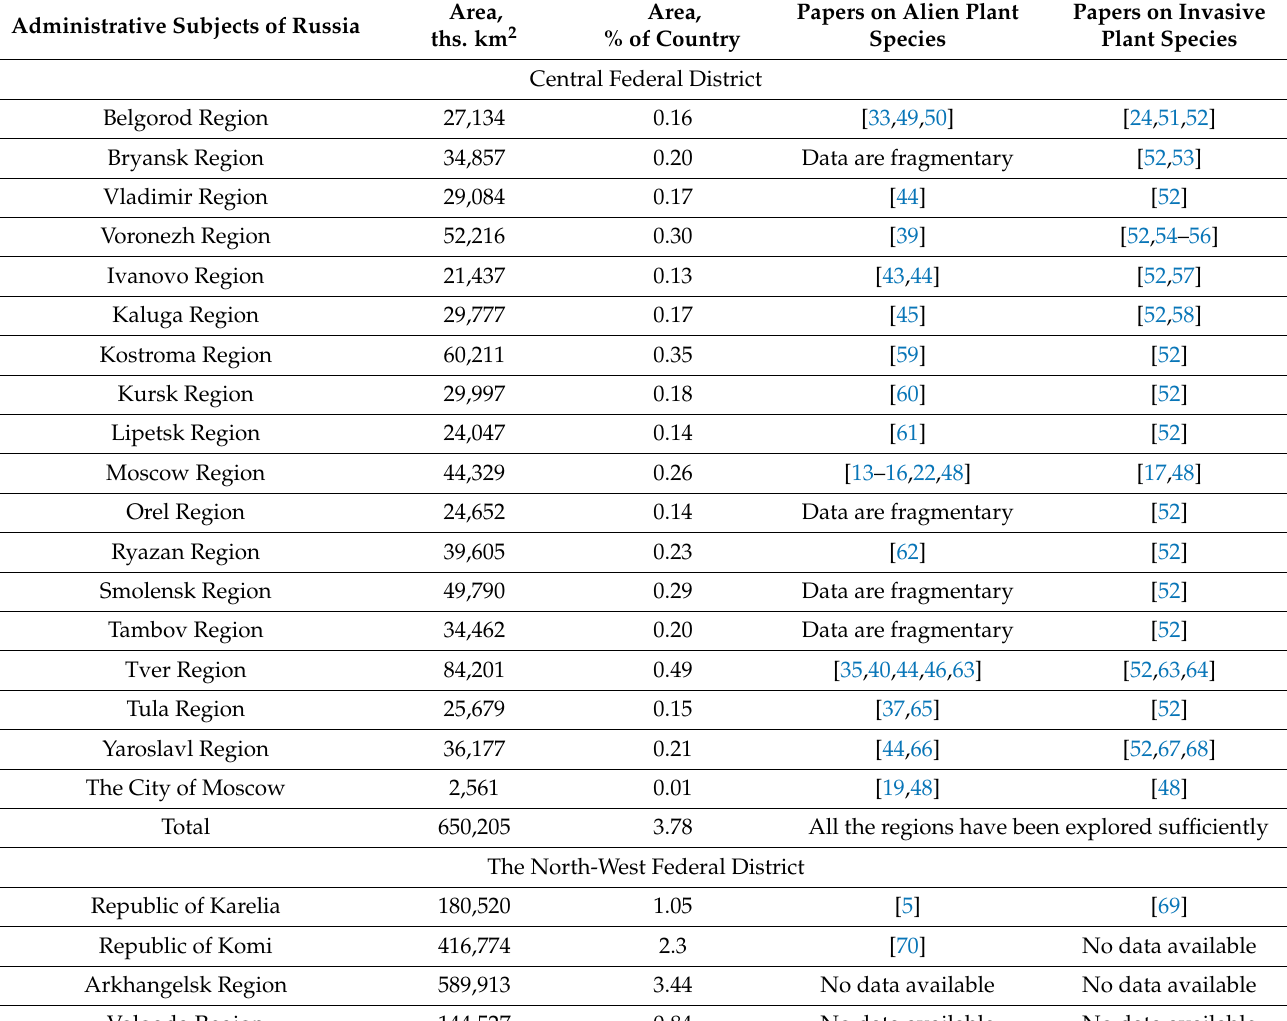
Table 1. The study of alien and invasive flora fractions in various administrative subjects of